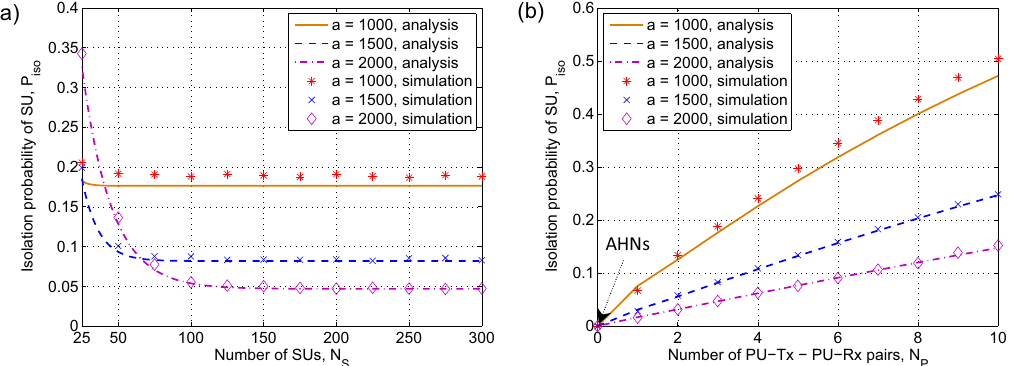
Figure 6. Probability of isolated SU versus ( a ) the number of secondary users, N S , and ( b ) the number of PU-Tx-PU-Rx pairs, N P , with different network sizes, a . λ P = 0.3, R T = r T = 250 m, R I = r I = 280 m; N P = 3 for ( a ) and N S = 300 for ( b ).